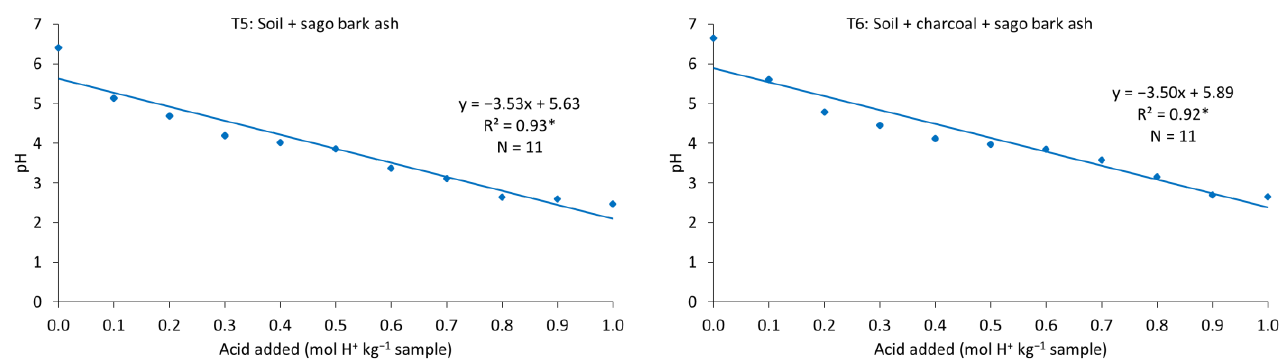
Figure 1. Linear regression between dilute sulphuric acid added (mol H + kg − 1 sample) and pH of suspension, where asterisk (*) represent significant difference at p ≤ 0.05 .